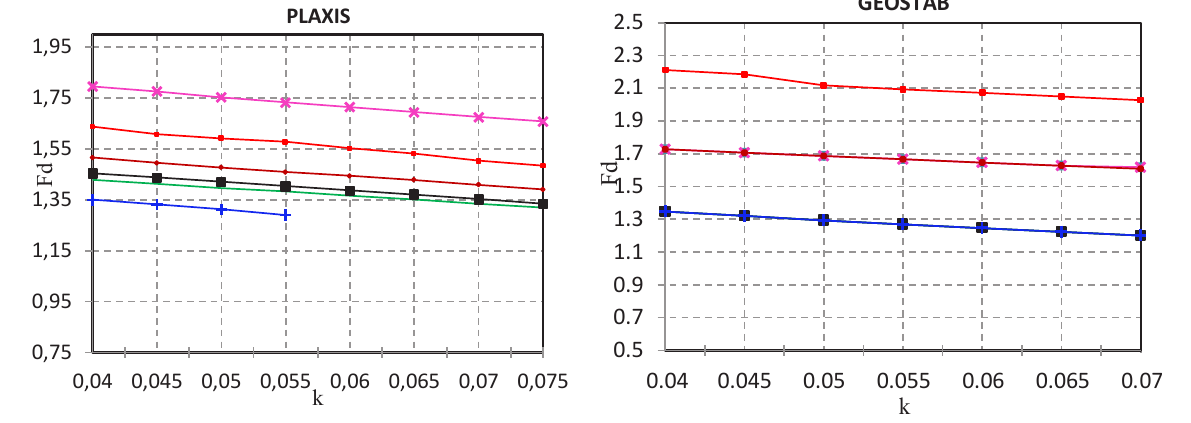
Figure 12: Effect of the upstream sloping core with PLAXIS and